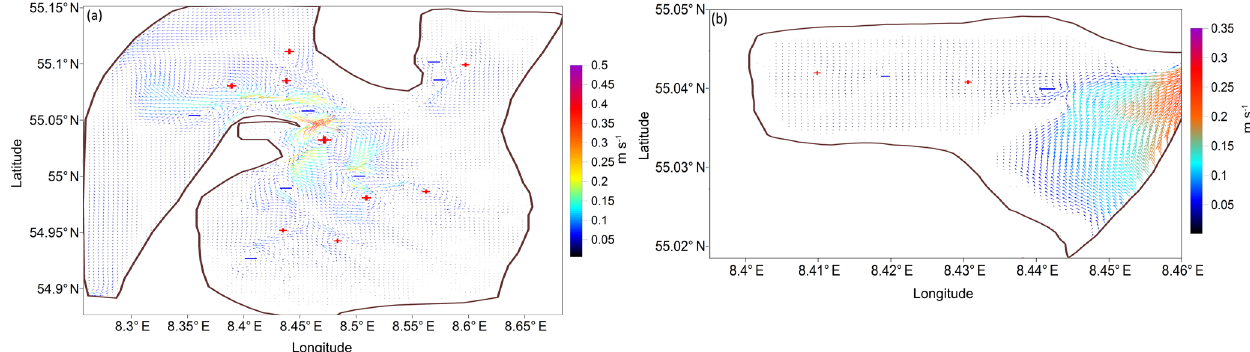
Figure 6. Residual circulation of the summary tide for (a) the whole area considered and (b) the Königshafen embayment. The “ + ’‘ and “ − ” symbols illustrate the clockwise and anticlockwise rotation, respectively, of the major gyres present in the system. The residual circulation is demonstrated on the unstructured